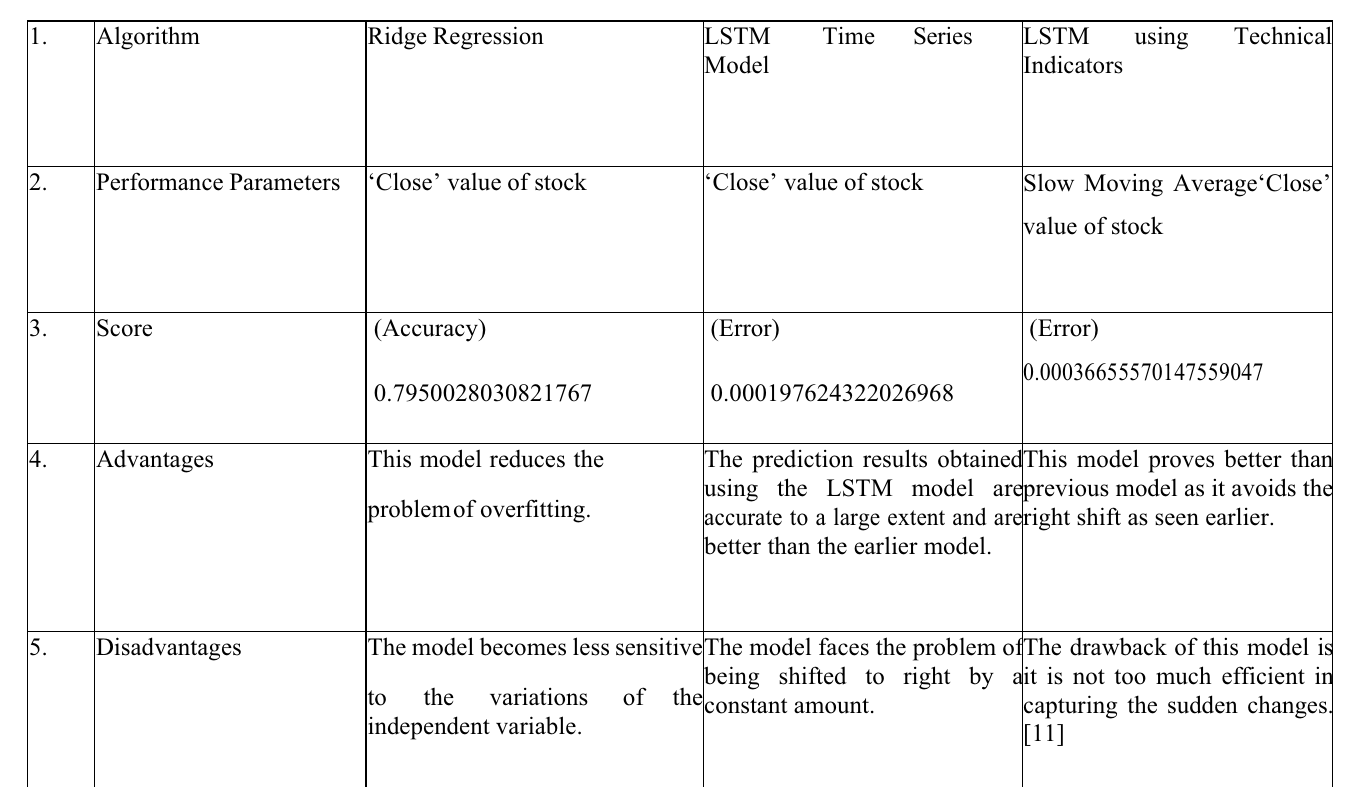
Table 1. Comparison of